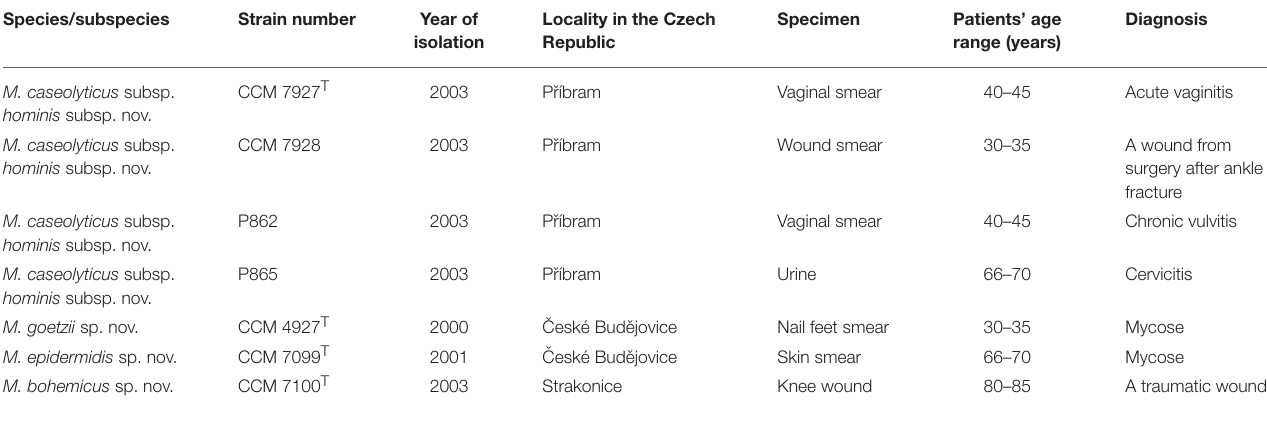
TABLE 1 | Source of human Macrococcus spp. strains characterized in this